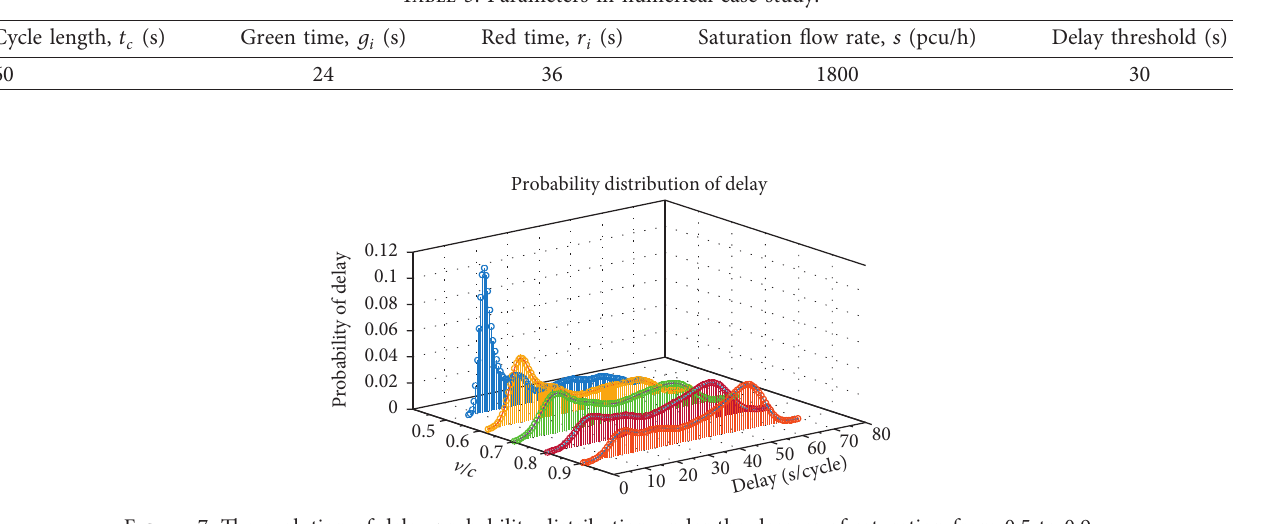
Figure 7: The evolution of delay probability distribution under the degrees of saturation from 0.5 to 0.9.